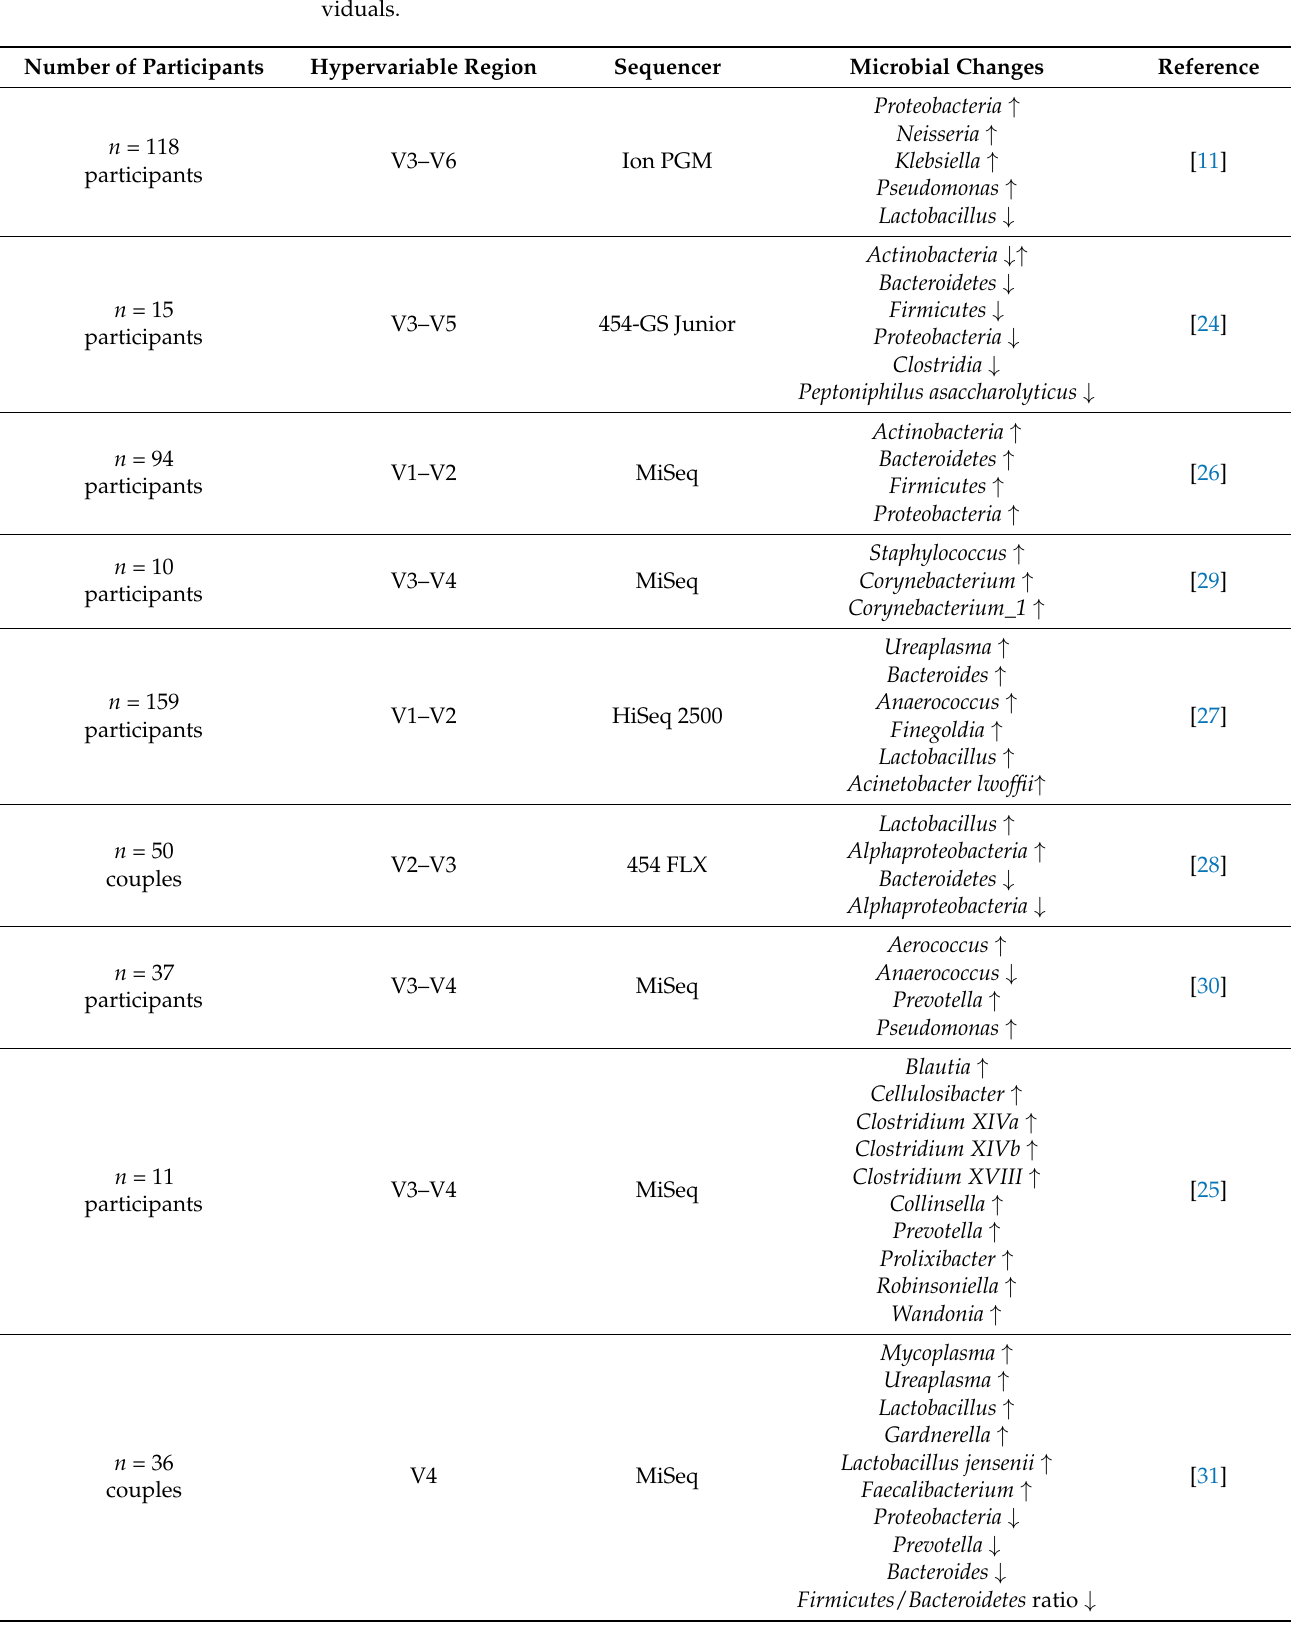
Table 1. Summarization of the studies in which the authors sequenced the 16S rRNA in human indi-